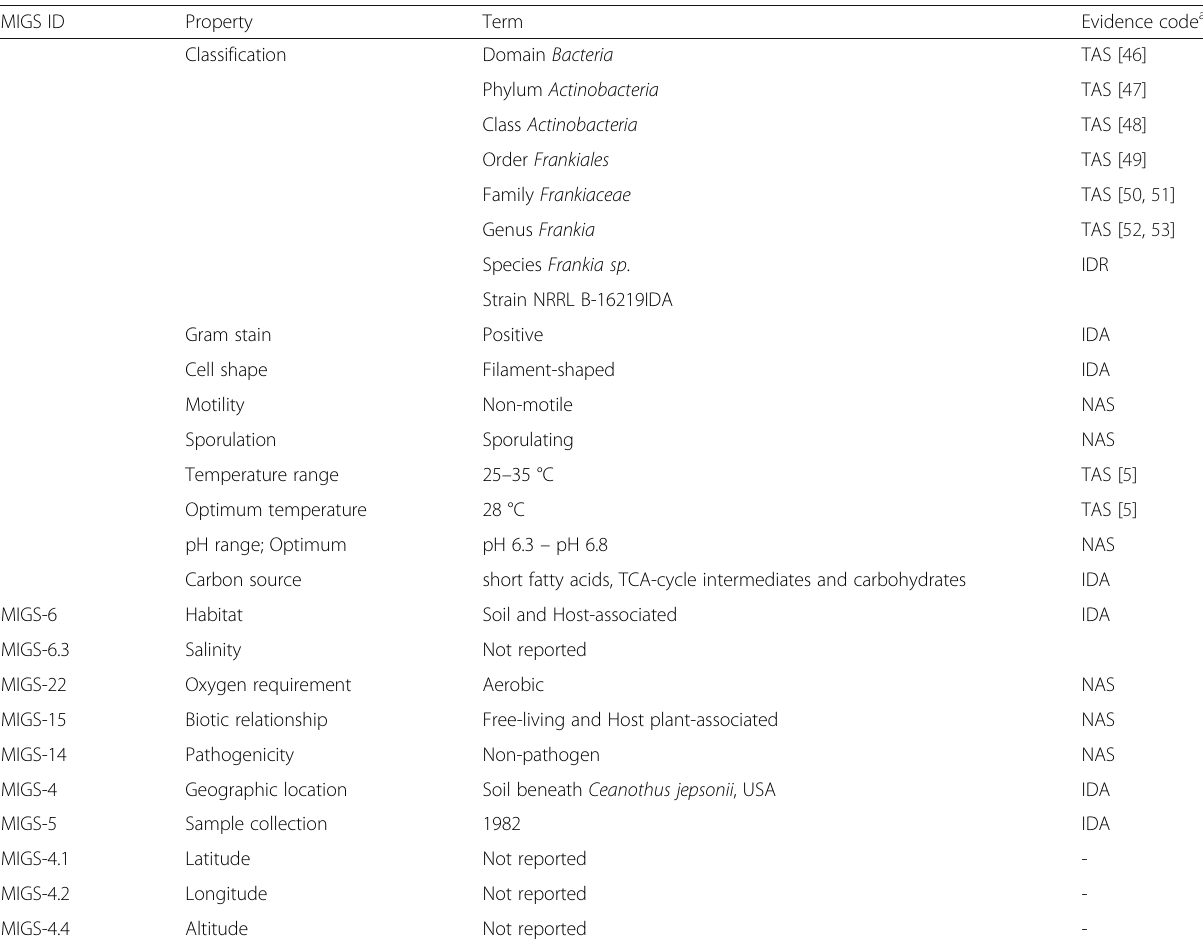
Table 1 Classification and general features of Frankia sp. strain NRRL B-16219 according to MIGS